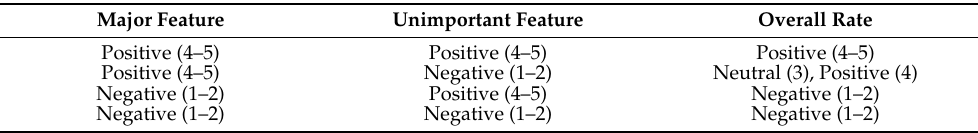
Table A2. Annotation standard of the twitter dataset (LFSC-T).